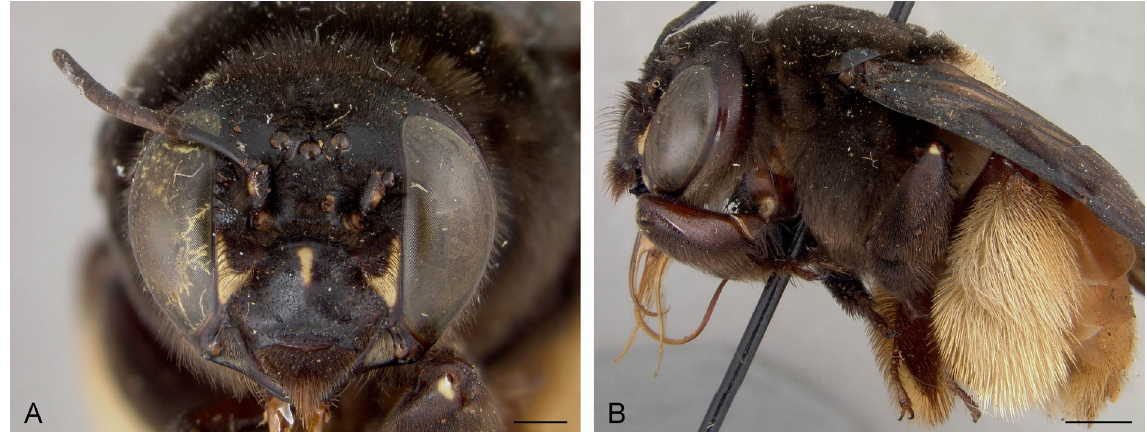
Fig. 28. Centris schwarzi Cockerell, 1919, holotype, ♀ (NMNH; USNM ENT 00534214). A . Frontal view. B . Habitus, lateral view. Scale bars: A = 1 mm; B = 2